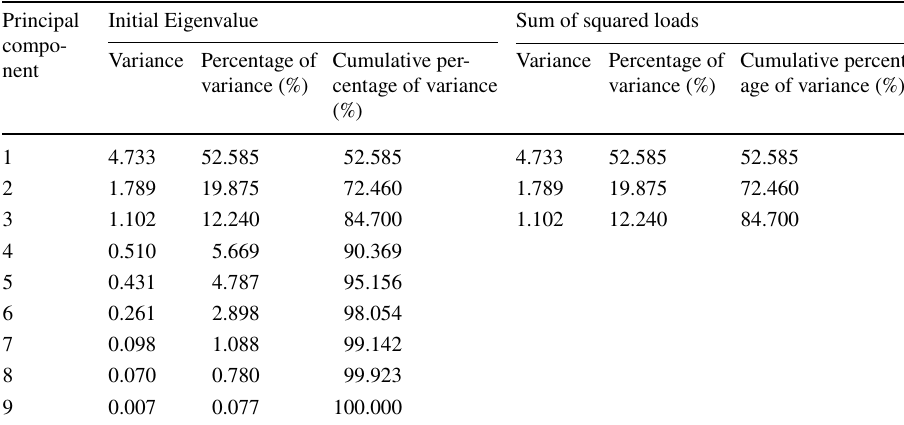
Table 2 Eigenvalues of the correlation coefficient matrix and their corresponding contributions to variance